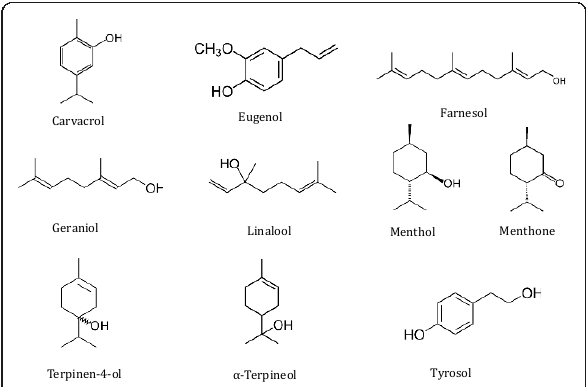
Figure 1 Formulae of the eight terpenic derivates (carvacrol, farnesol, geraniol, linalool, menthol, menthone, terpinen-4-ol, and a -terpineol), the phenylpropanoid (eugenol) and the phenethyl alcohol (tyrosol) studied